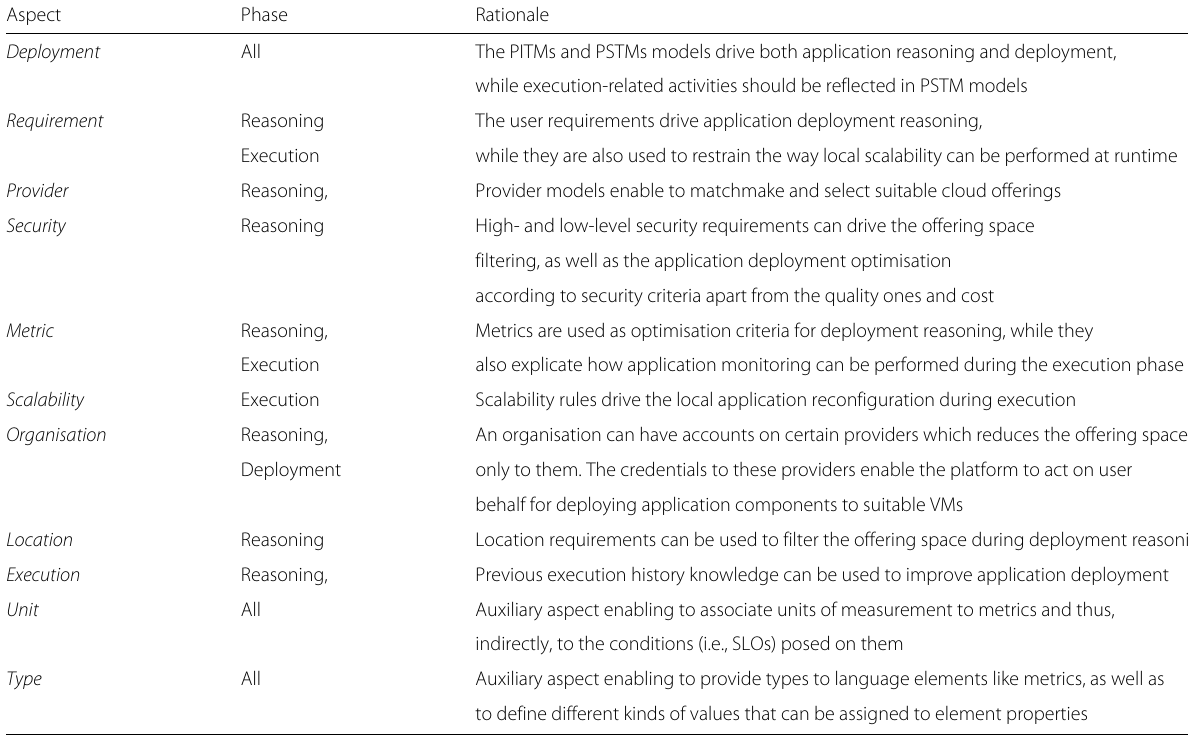
Table 1 The relevant aspects for multi-cloud application management Aspect Phase